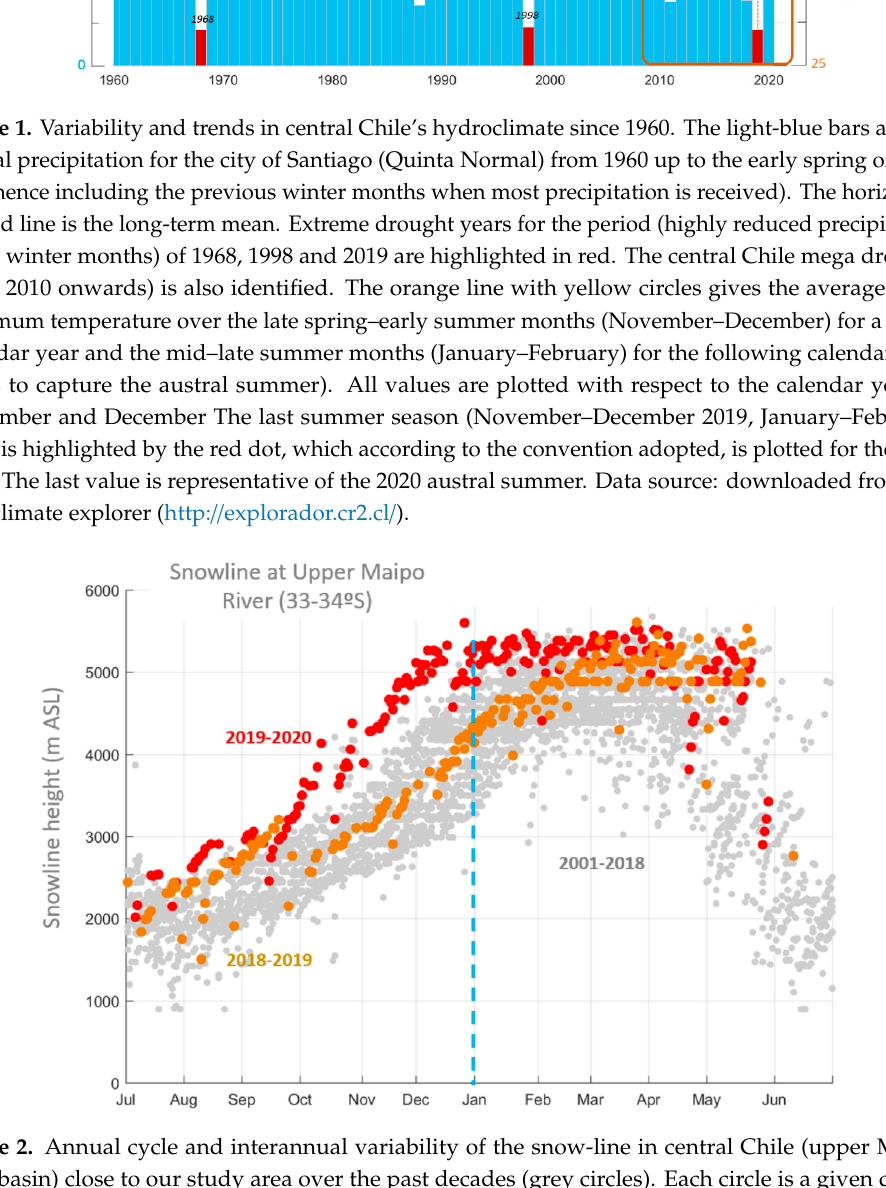
Figure 2. Annual cycle and interannual variability of the snow-line in central Chile (upper Maipo river basin) close to our study area over the past decades (grey circles). Each circle is a given day in a year. The period July 2018–June 2019 is highlighted in orange and the period July 2019–June 2020 (extreme drought) is highlighted in red.